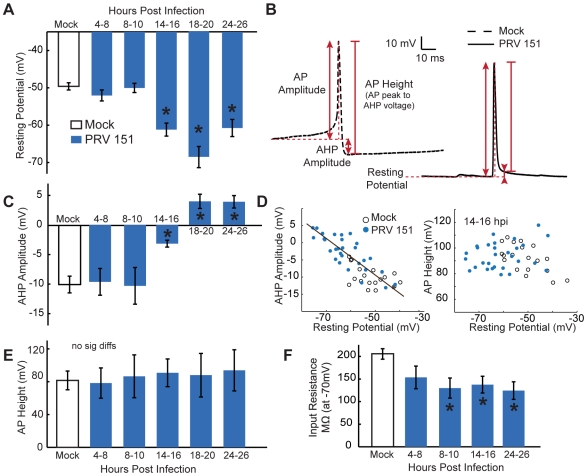
Time course of PRV induced changes in resting membrane potential and AP shape.(A) Resting membrane potentials of PRV 151 infected neurons were similar to mock-infected neurons before 14 hpi and were hyperpolarized for the duration of the times measured. (B) Example traces of spontaneous AP, representative of means at 14–16 hpi. Horizontal dotted red lines denote resting membrane potential, the first solid vertical arrowed line indicates AP amplitude, the second solid vertical arrowed line represents AHP amplitude, and the third vertical red line represents AP height (difference between the peak of AP amplitude and the voltage measured for AHP). (C) AHP amplitude remained comparable to mock-infected neurons until 14 hpi, and was more positive for the duration of the time course. (D) More positive AHP amplitudes correlated with resting voltages similarly for PRV 151 and mock-infected neurons, example shown at 14–16 hpi. Linear fits: in black, to all conditions, y = −.50x−34.3 R2 = 0.68, to mock condition y = −.20x−20.15 R2 = 0.26, and to PRV 151 at 14–16 hpi, y = −0.54x−36.17 R2 = 0.73. No trend was observed in AP height as a function of resting voltage. (E) Total peak AP to AHP minimum in infected neurons did not change significantly from mock infected for at least 24 hours. (F) Input resistance of infected neurons became increasingly lower in magnitude as infection proceeded. Resistance measured from points in a 10 mV range surrounding −70 mV. (A–E) Mock n = 19, 4–8 PRV 151 n = 12, 8–10 hpi n = 7, 14–16 hpi n = 9, 18–20 n = 4, 24–26 n = 14. (F) Mock n = 14, 4–8 hpi PRV 151 n = 5, 8–10 hpi n = 4, 14–16 hpi n = 9, 24–26 hpi n = 5.